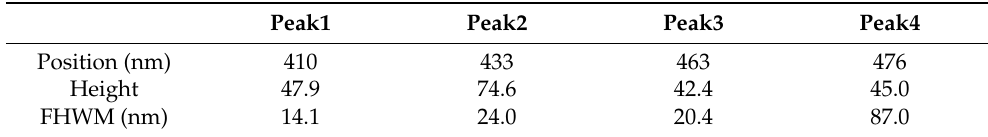
Table 4. Low-temperature fluorescence parameters of fitted peaks for Cs 3 Bi 2 Cl 9 :Ce 30% QDs, results